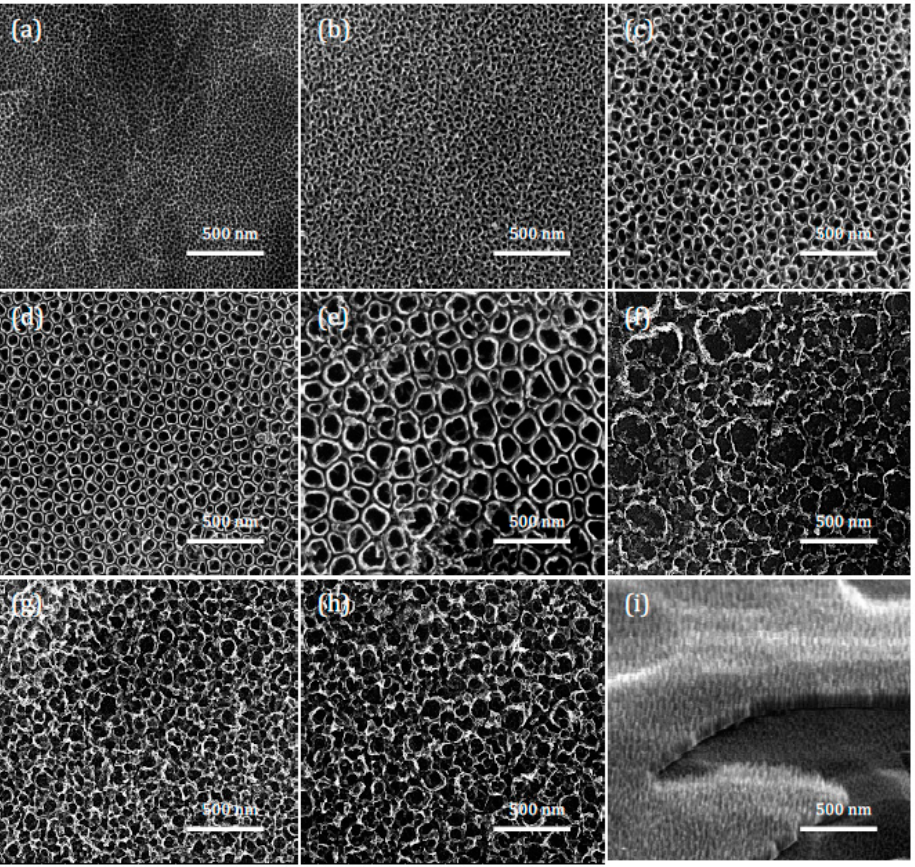
Figure 1. Scanning electron microscope (SEM) images of ( a ) TNT5, ( b ) TNT10, ( c ) TNT15, ( d ) TNT20, ( e ) TNT30, ( f )TNT40, ( g )TNT50, ( h )TNT60, ( i ) side view of TNT5. Numbers at titania nanotubes (TNT) are the potential in which the system was created.